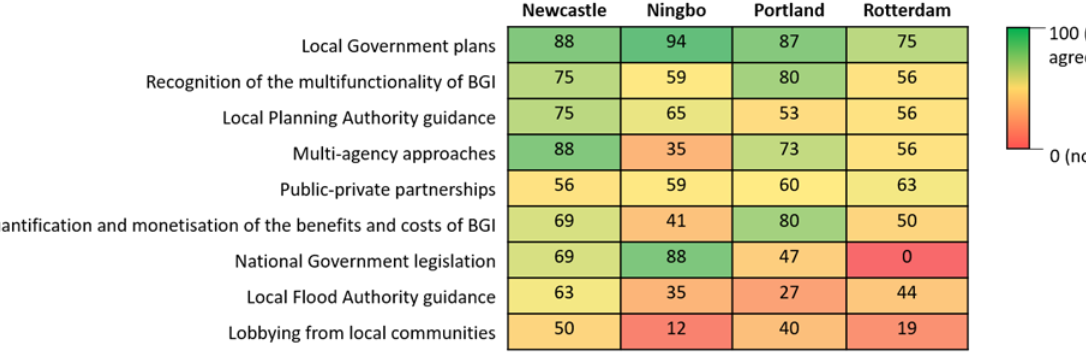
Figure 5. Level of agreement within cities regarding what drives implementation of BGI (Blue-Green Infrastructure). Values range from 0 (red = no members of the city group selected the drivers) to 100 (green = all members of the city group selected the drivers). Respondents could select multiple options. Physical process and risk drivers, e.g., impacts of climate change, were not included in this question (see Supplementary Material).